Question: Based on the figure, does the quantity rise or fall?
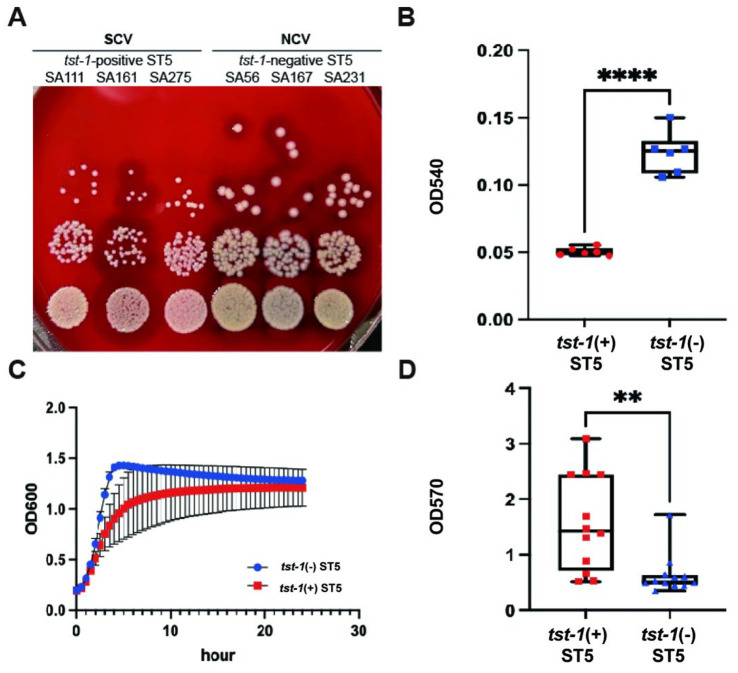
Answer: increasing